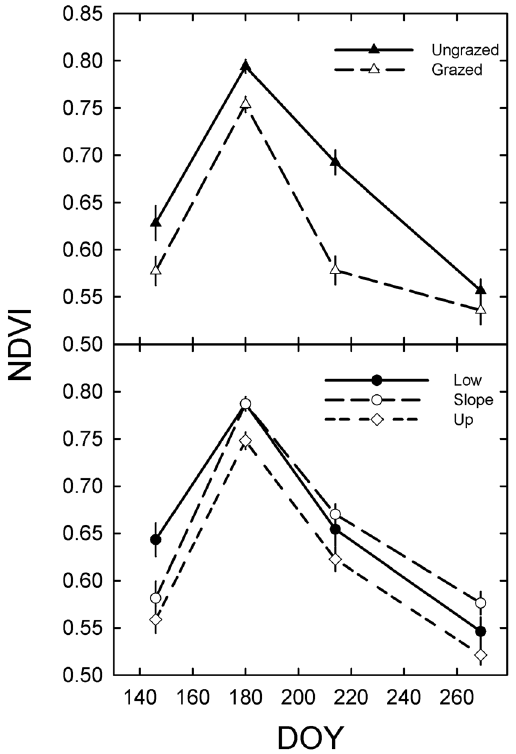
Figure 4. Changes in mean NDVI ( ± 1SE) by day of year in 2011. Each estimate of NDVI represents the image captured at , 2 6 2 m resolution for each individual dogwood island on the landscape. Panel ‘a’ shows differences according to topographic positions, while panel ‘b’ shows differences by grazing contrasts.